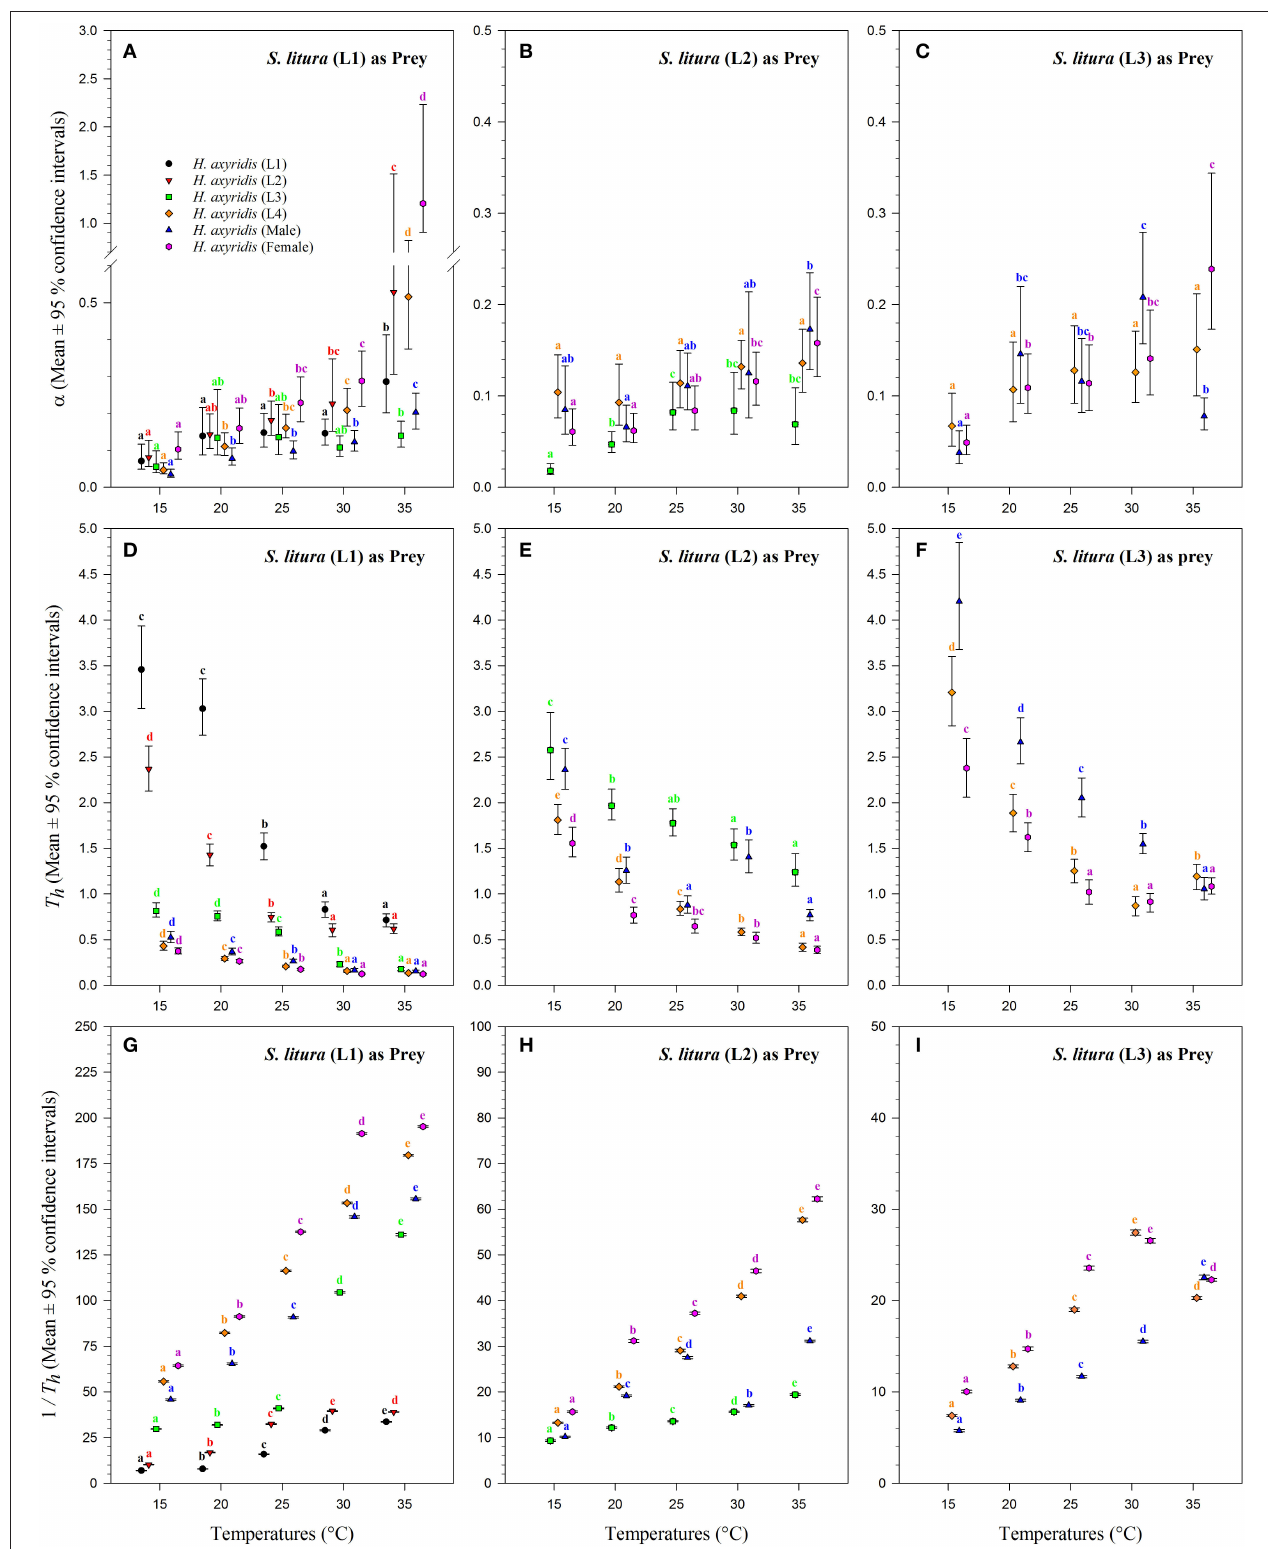
FIGURE 6 | Functional response coefficients of Harmonia axyridis foraging on 1st, 2nd, and 3rd instars of Spodoptera litura under different temperatures. Mean ± 95% confidence intervals of space clearance rate [ a (A–C) ], handling time [ T h (D–F) ], and maximum predation rate [1/ T h (G–I) ] were estimated from